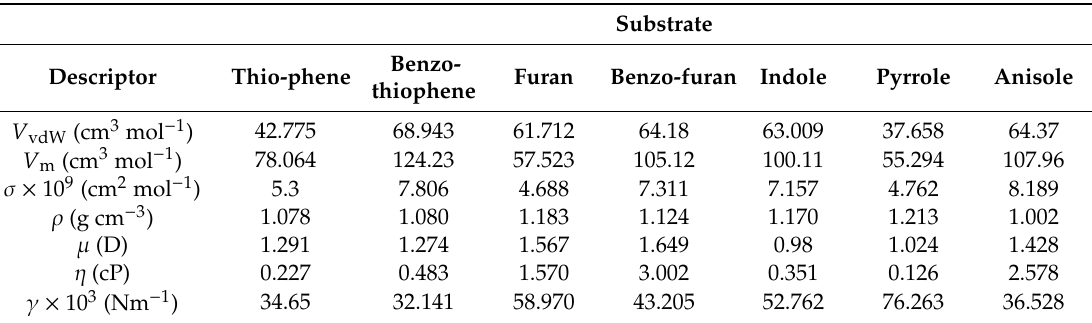
Table 5. Substrate descriptors a used in this